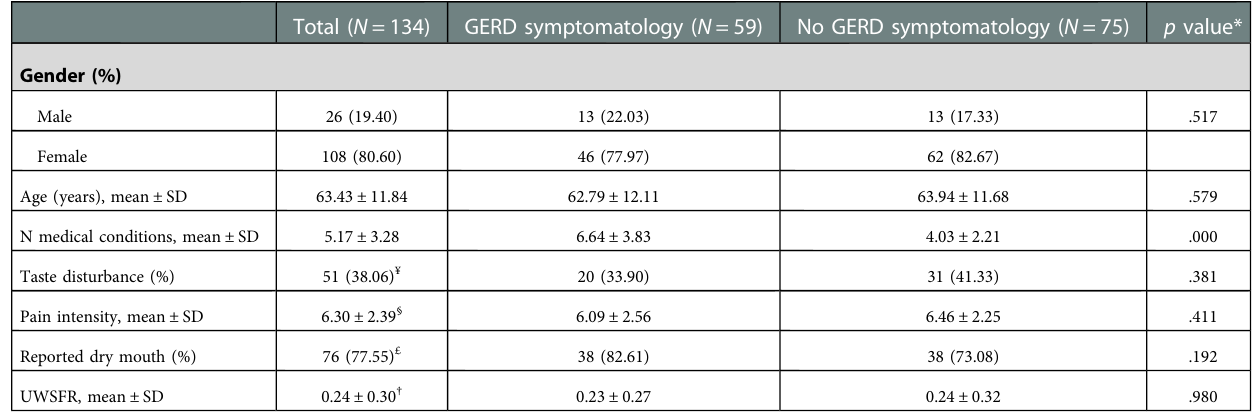
TABLE 1 Characteristics of the study population and differences between participants with and without GERD